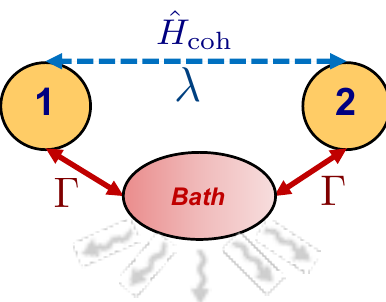
Figure 6: Schematic showing the basic setup for generating an arbitrary non- reciprocal interaction between two quantum systems 1 and 2. We start with a co- herent Hamiltonian interaction ˆ H between the two systems involving the product coh of operators ˆ O and ˆ O for each system, with an interaction strength λ . By introduc- 1 2 ing correlated dissipation on both systems in just the right way (via coupling to a common reservoir at rate Γ ), a non-reciprocal interaction can be